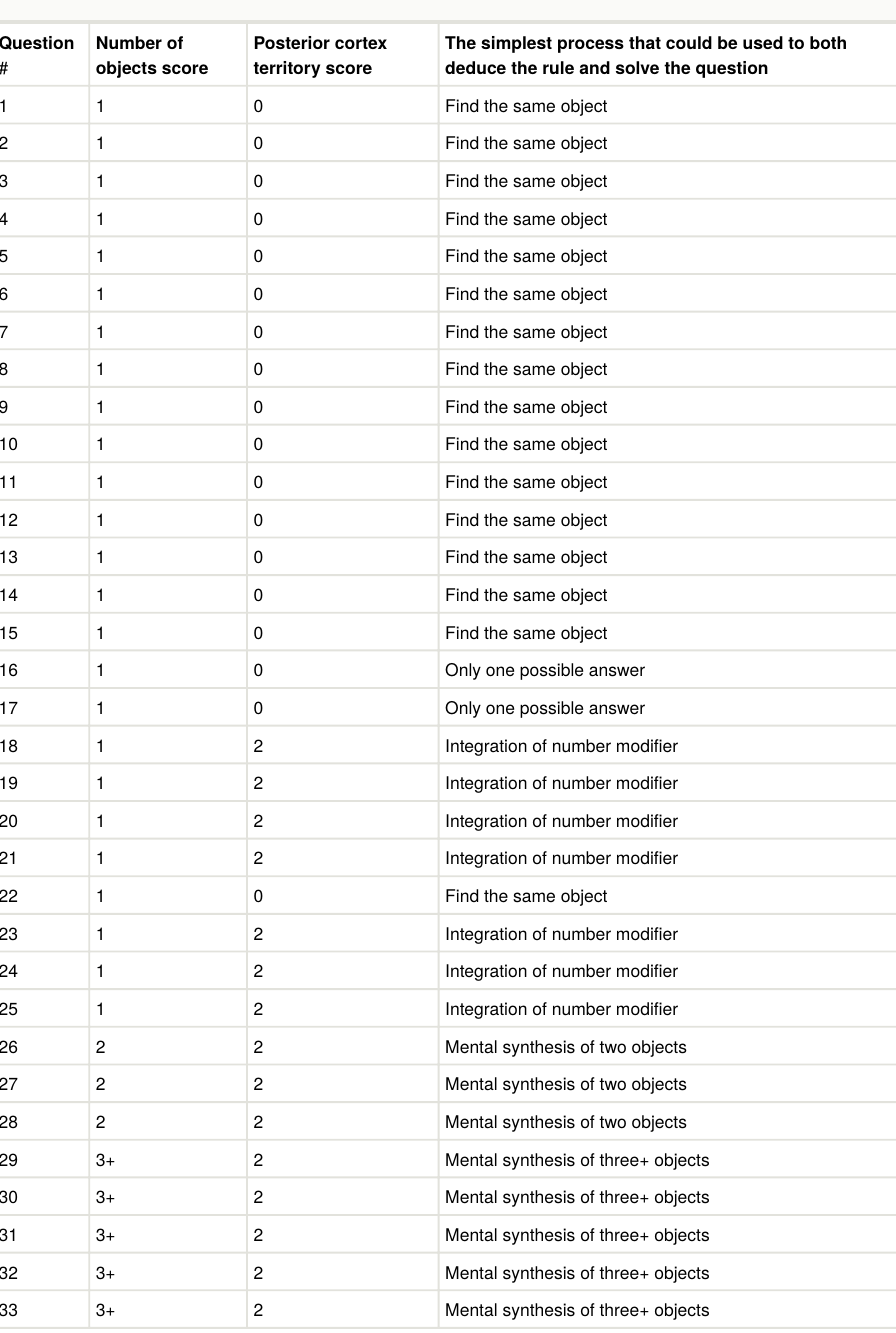
Table 7. Panel assignment of mental processes for WISC-V,